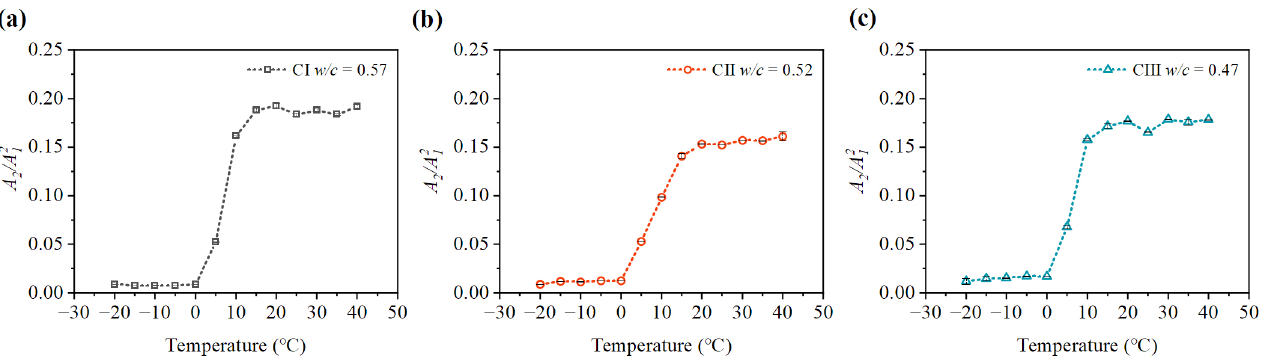
at different temperatures (day 7): ( a ) nonlinear 1 of CII; ( c ) nonlinear parameter A 2 / A 2 1